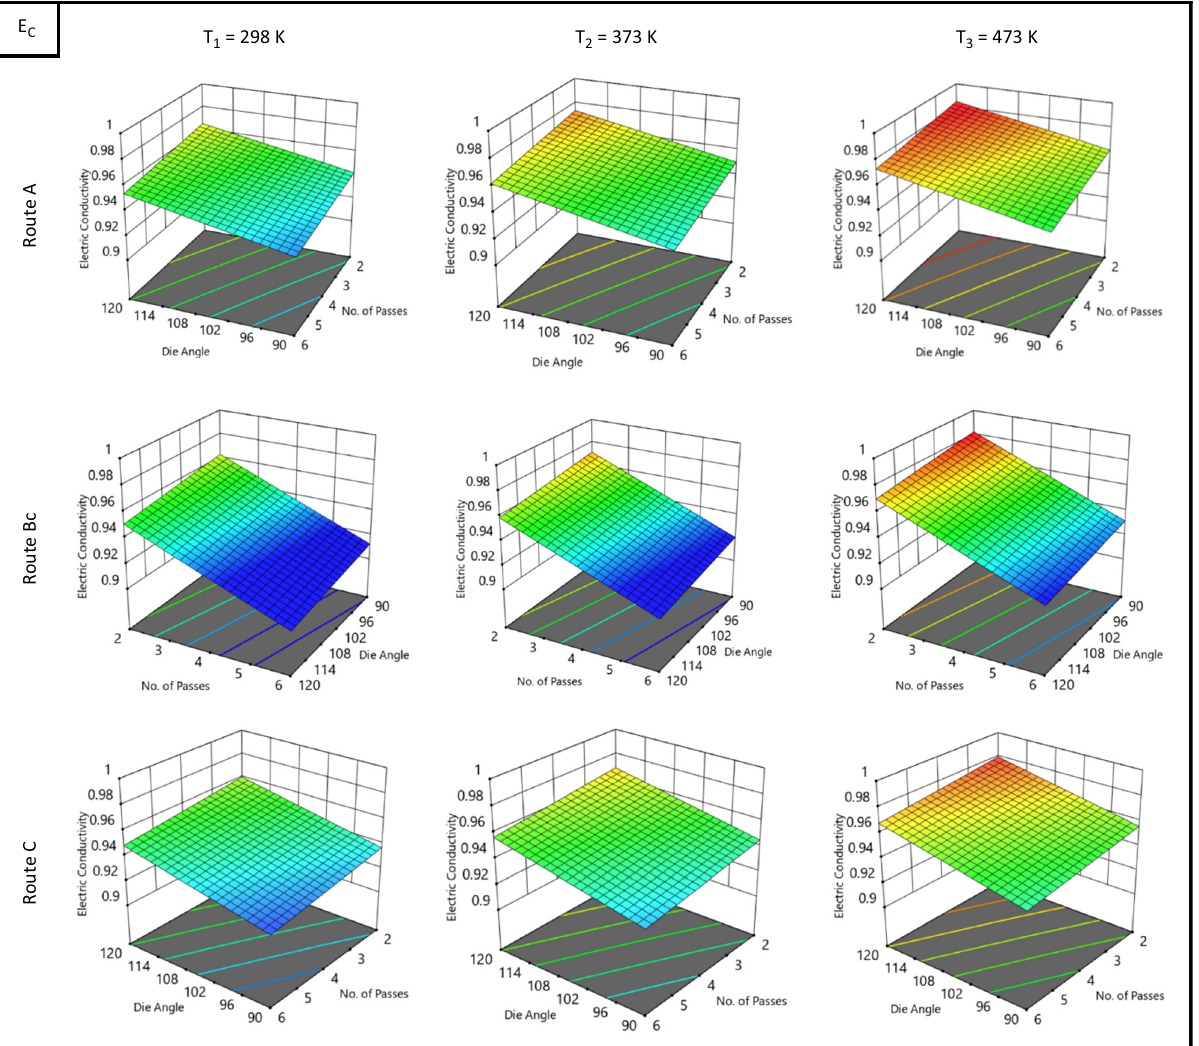
Figure 18: Response surface plot of E C as a function of die angle, number of passes, route type, and processing